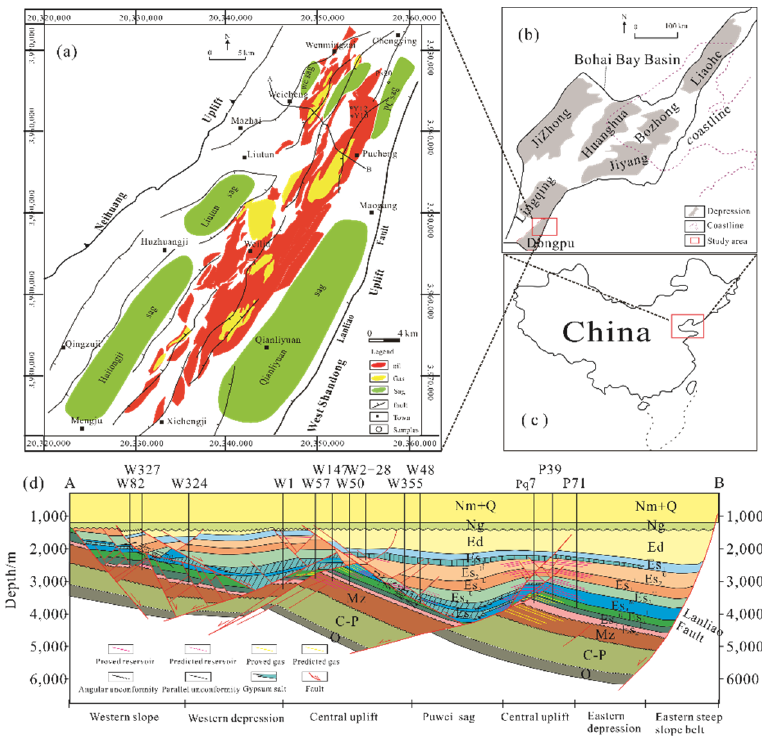
Figure 1. Location of the study area ( a ) on the background of Bohai Bay Basin ( b ) of China map ( c ), and sedimentary profile marked on the map with tectonic line A-B ( d ) according to [18].